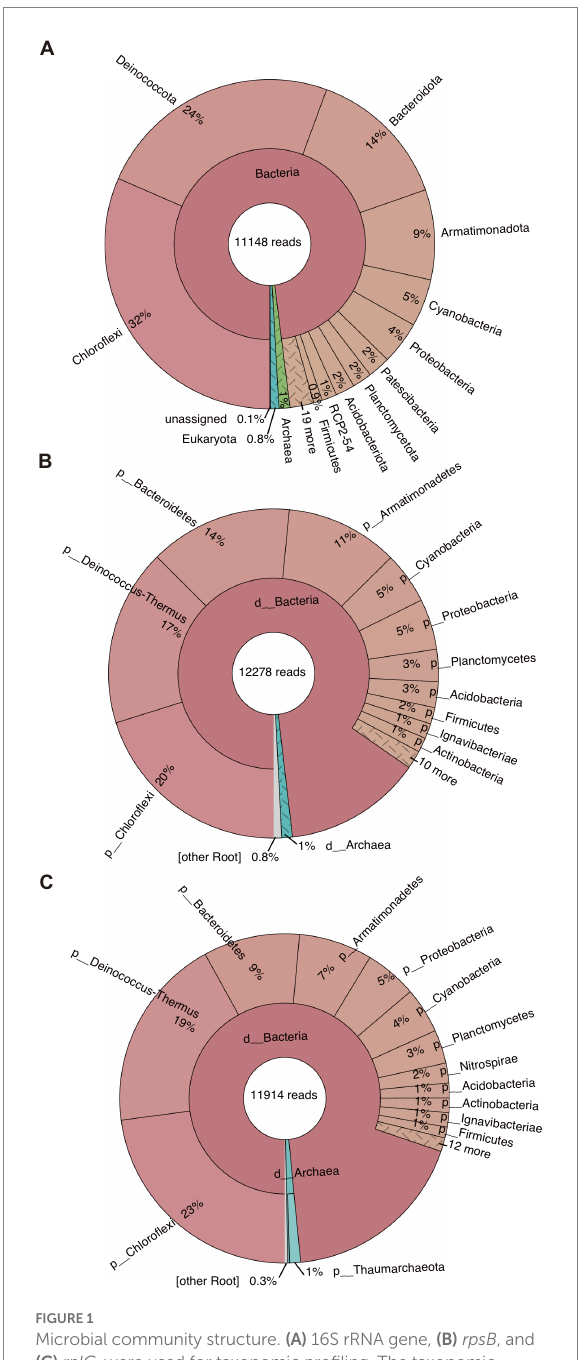
FIGURE 1 Microbial community structure. (A) 16S rRNA gene, (B) rpsB ,